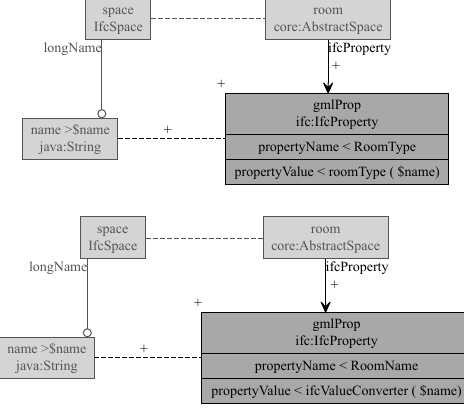
Figure 12. Rules that share the same left-hand side with nodes of types IfcSpace, java:String and